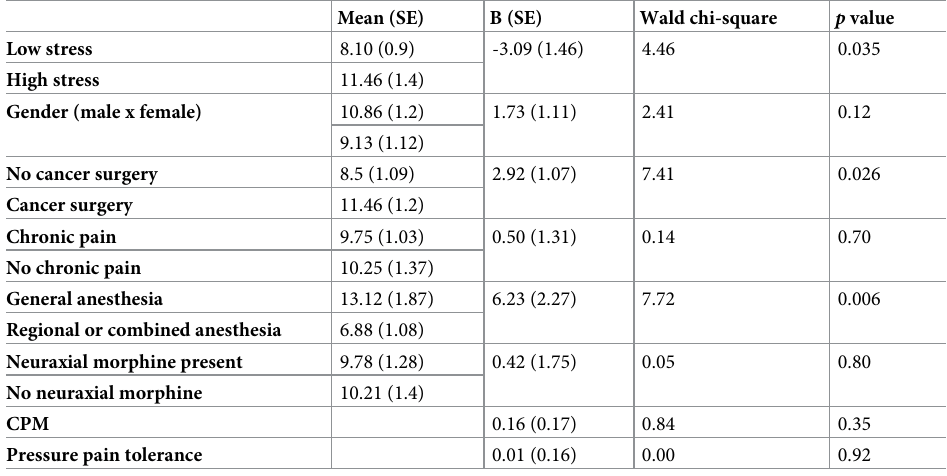
Table 7. Generalized linear model with dependent variable morphine consumption in 48 hours. Mean (SE) B (SE)